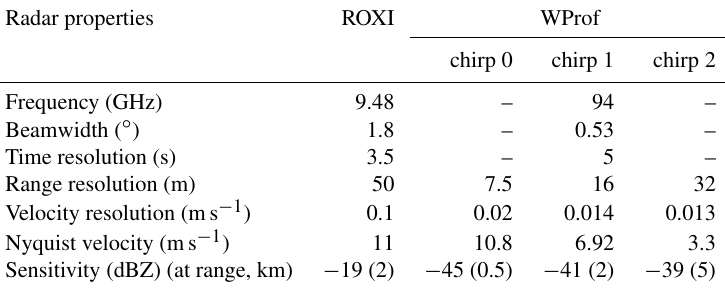
Table 2. Parameters of ROXI and WProf radars during the ICE GENESIS deployment. WProf range and time resolution (as well as Nyquist velocity) are defined in three chirps. The lower chirp ranges from 100 to 900m, the second one from 900 to 3900m, and the higher one from 3900 to